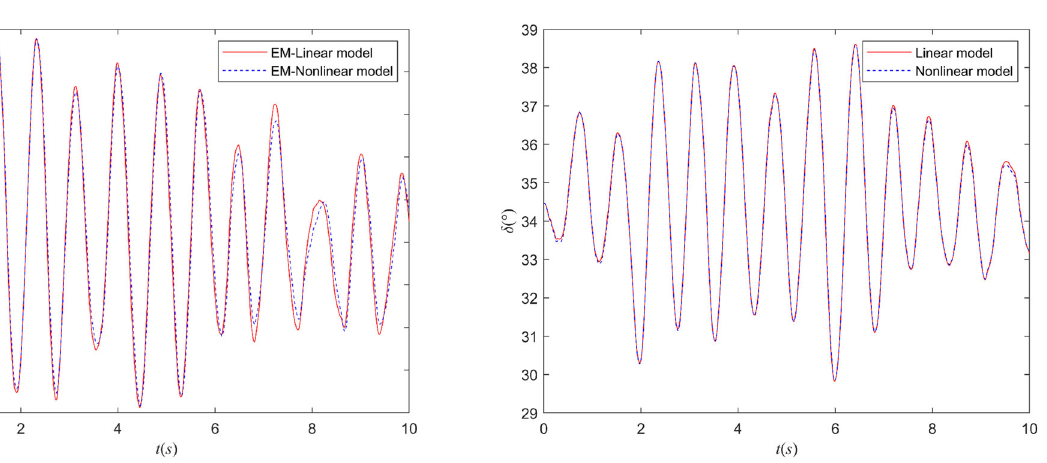
Fig. 5 Comparison of power angle curves between linear and nonlinear models of the system ( σ =